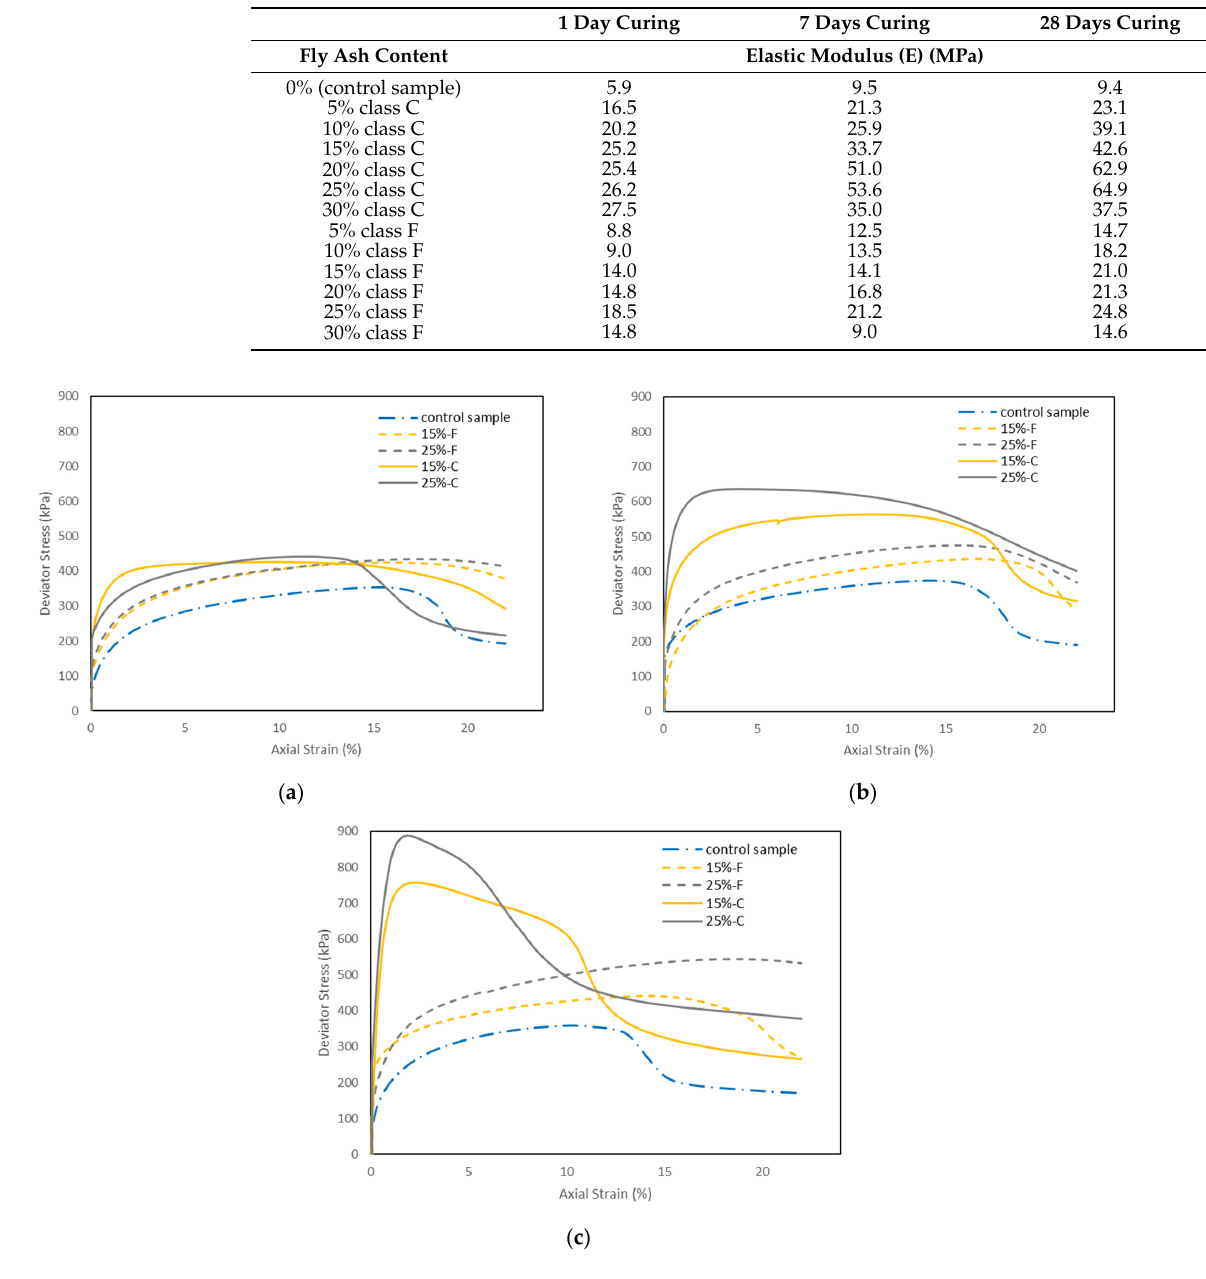
Figure 8. Stress-strain behavior of control sample and soil samples stabilized with class C and class F fly ash at a confining pressure of 600 kPa at ( a ) one day of curing, ( b ) seven days of curing, ( c ) 28 days of